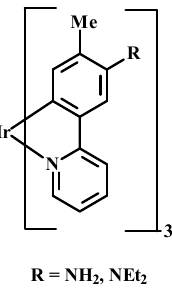
Figure 5. Examples of pH responsive Ir(III) complexes.